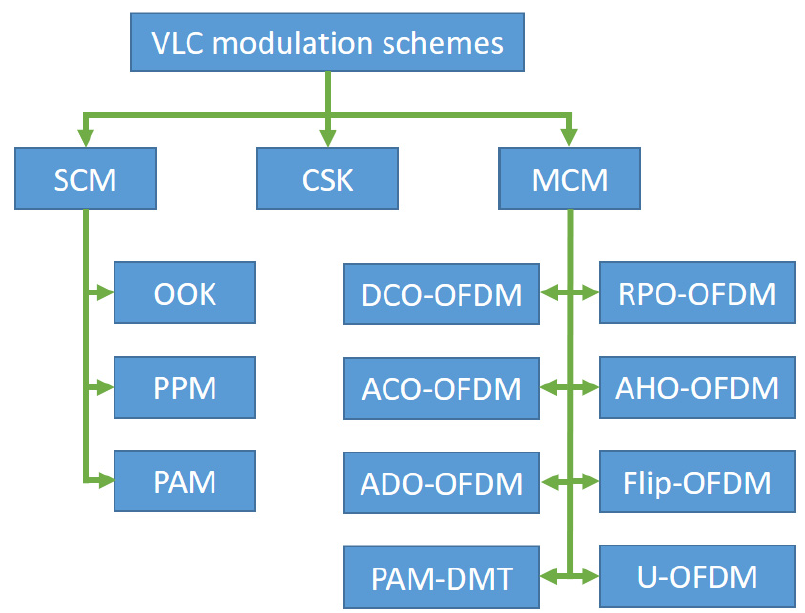
Figure 3. VLC modulation schemes.